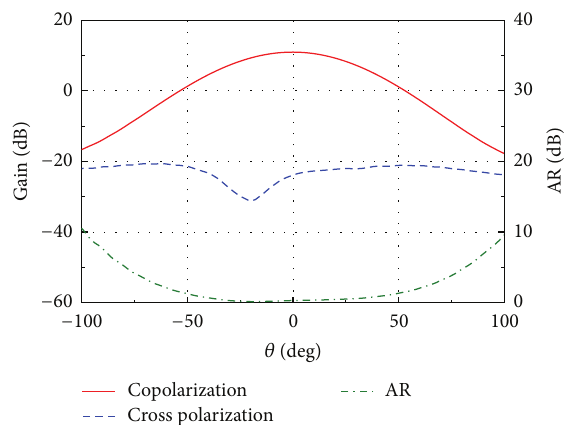
Figure 4: Simulated radiation patterns and AR of the horn antenna (2.2 GHz).